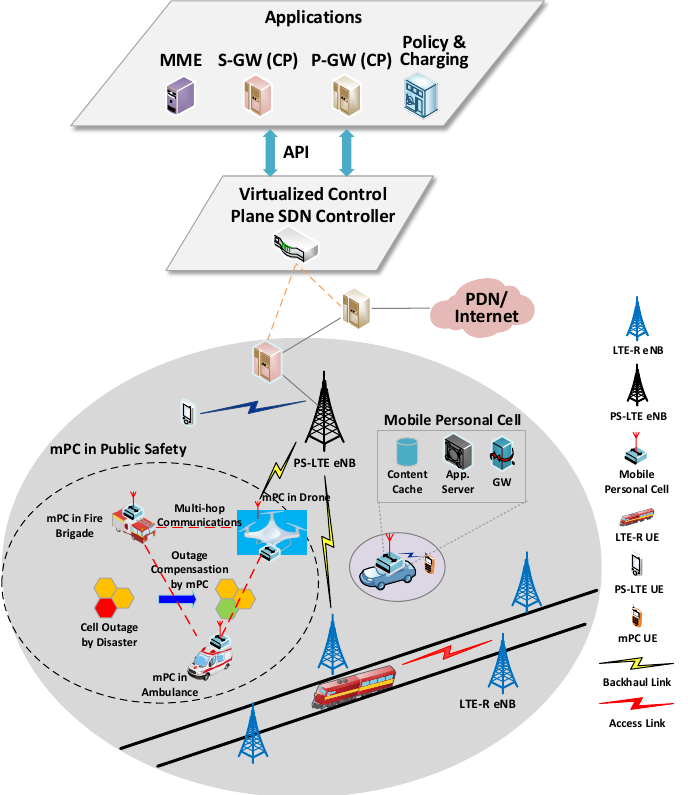
Figure 1. Mobile personal cell (mPC) deployments based on public safety situations.